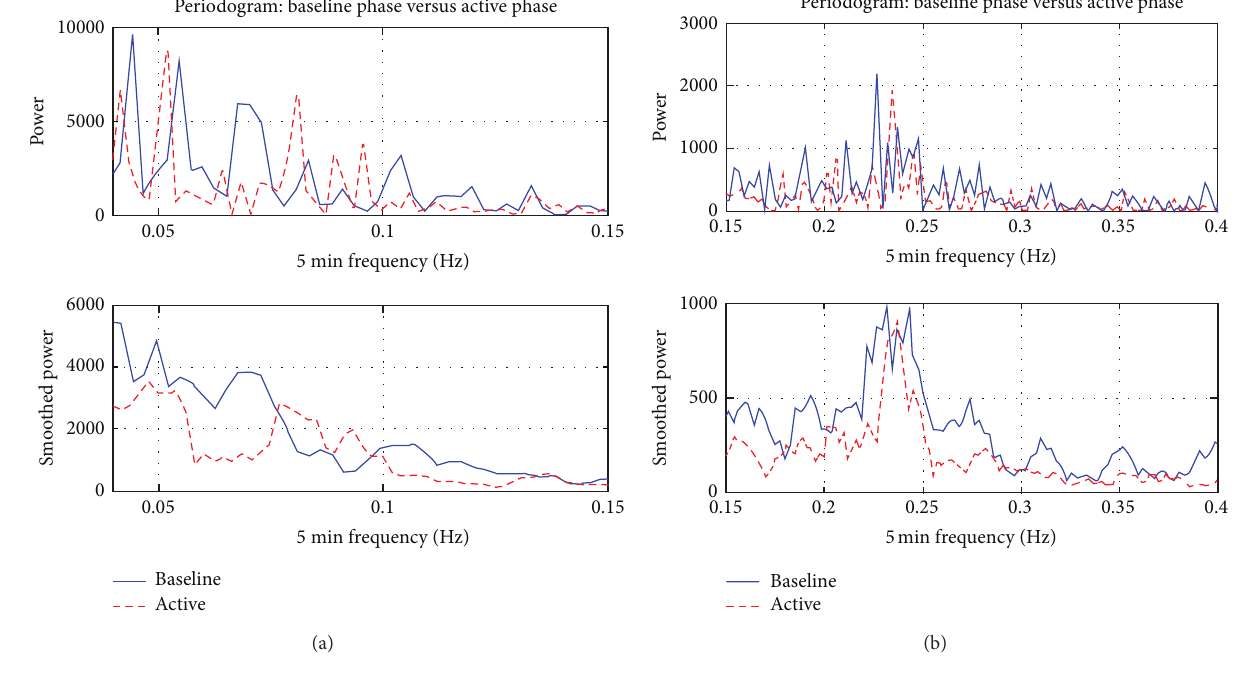
Figure 9: Power spectrum: (a) corresponds to LF and (b) to HF components.